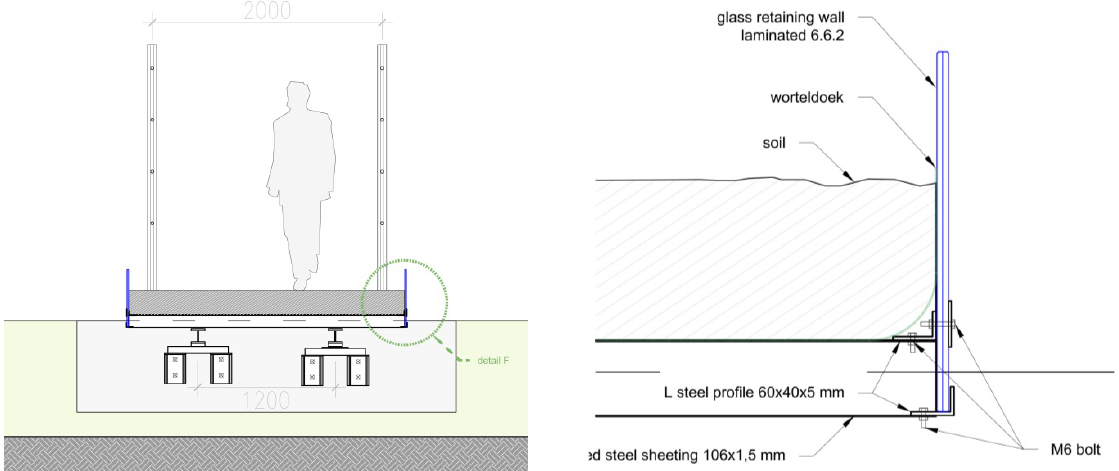
Fig. 3 section of the glass truss bridge with detail of glass retaining